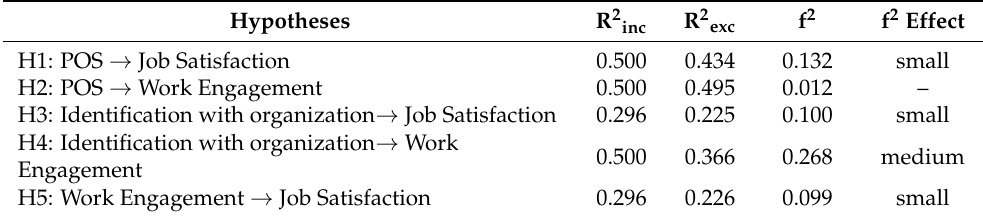
Table 4. R 2 and f 2 results for proposed model’s constructs.